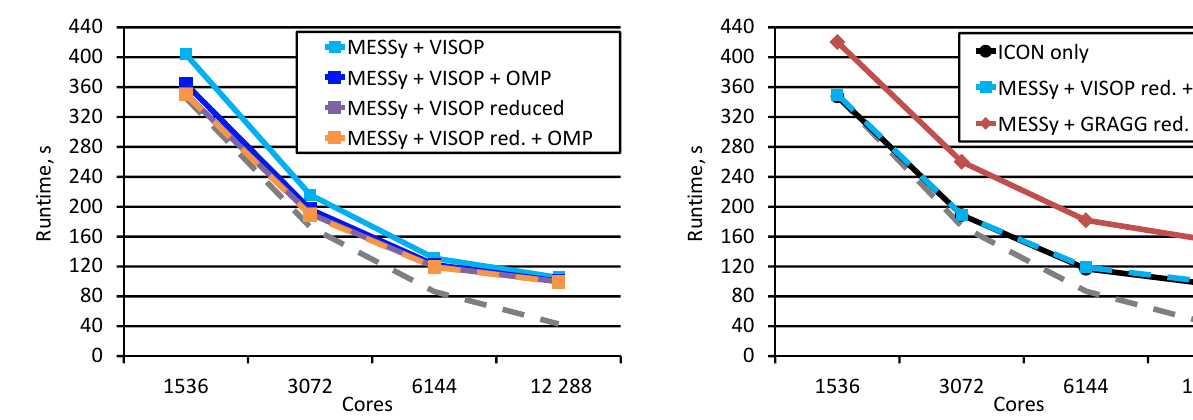
Figure 8. Comparison of the runtime (s) of “ICON only”, and the test cases with the lowest runtime for activated GRAGG and VISOP. Output was activated in all test cases. The dashed grey line marks perfect scaling for “ICON only” with activated